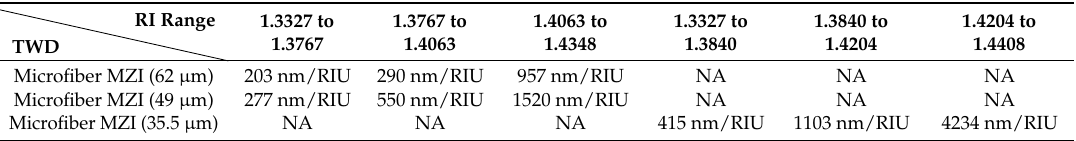
Table 2. The RI sensitivity of three microfiber MZIs with various TWDs and constant taper lengths are shown for different RI ranges.